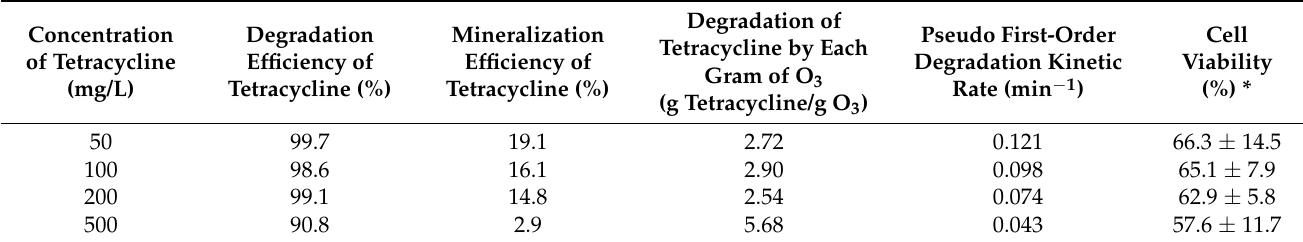
Table 2. Degradation and mineralization of tetracycline by ultrafine-bubble ozonation at different initial tetracycline concentrations (pH 3, temp. 25 ◦ C).